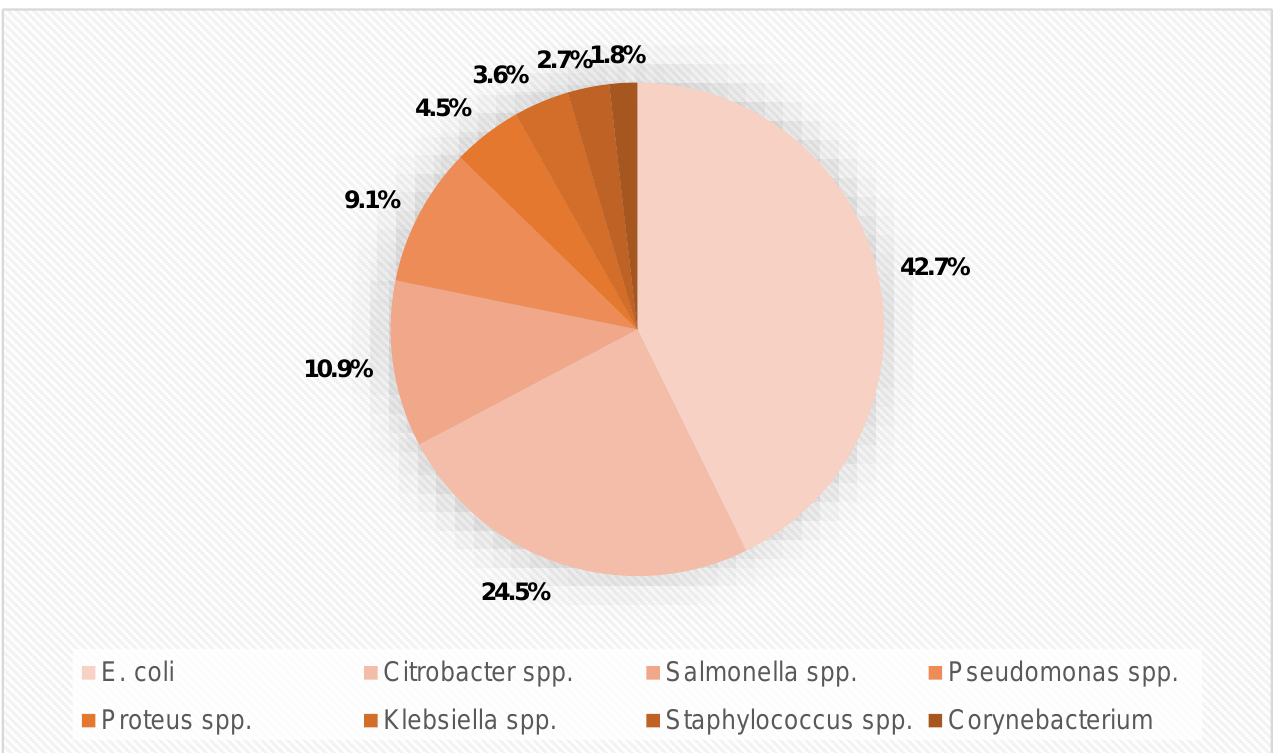
Figure 1. Distribution of bacterial species in n = 110 positive urine cultures in our study.